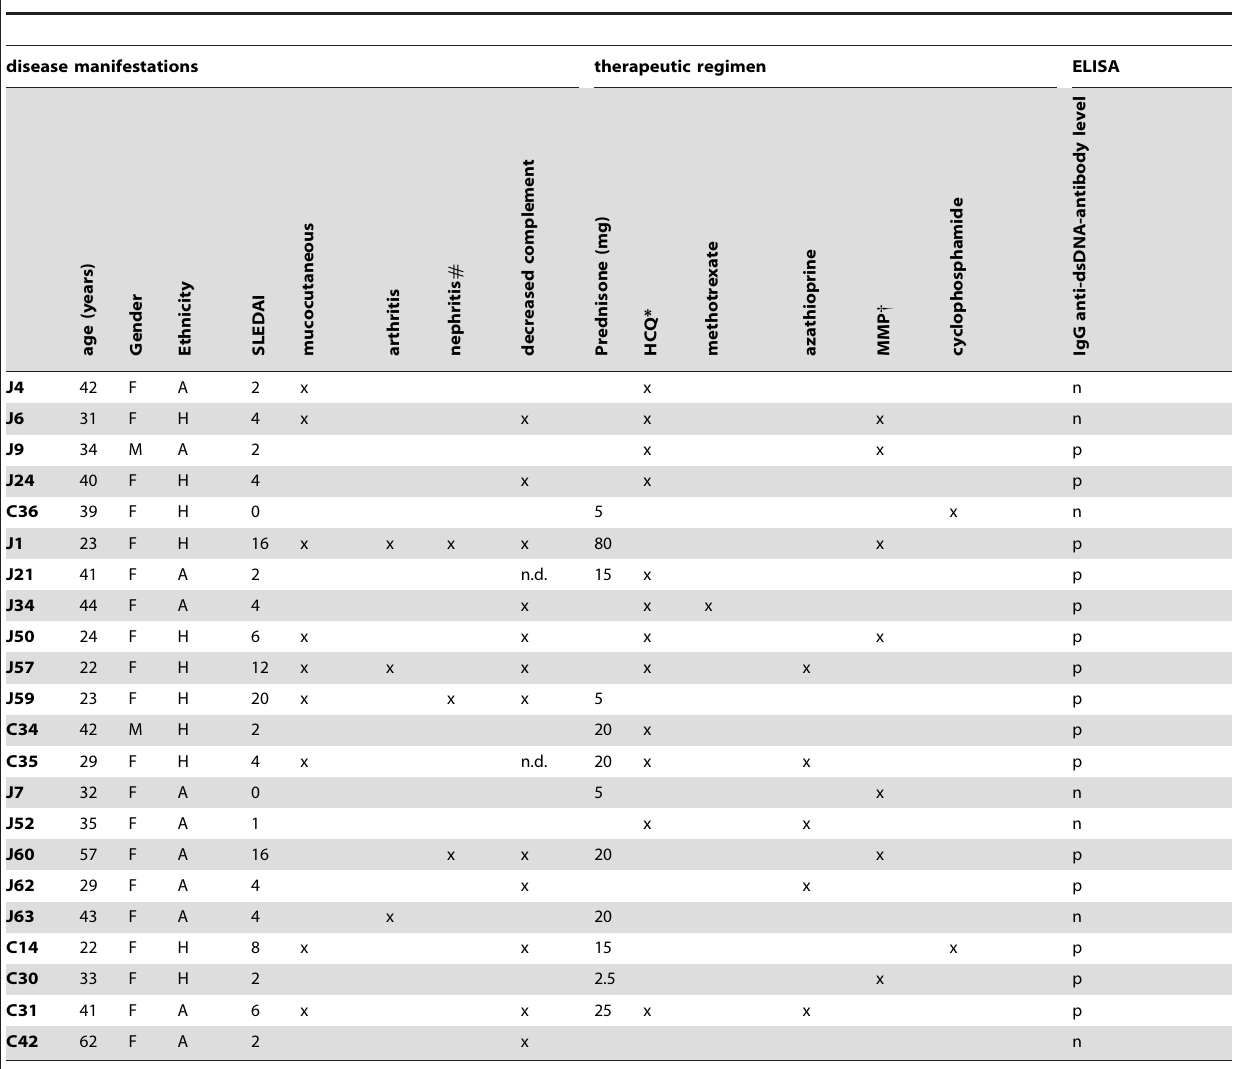
Table 1. Patient